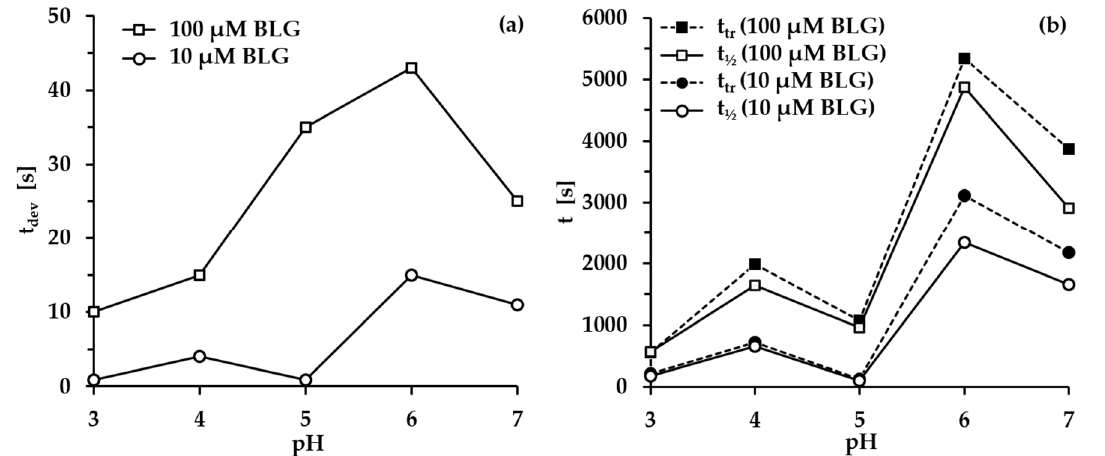
Figure 8. Characteristic times ( a ) t dev , ( b ) t ½ and t tr , for foams obtained from solutions at two BLG concentrations of 10 µM and 100 µM and various pH (C buff = 10 mM). Lines are guides to the eye. Each data point is one foam experiment.